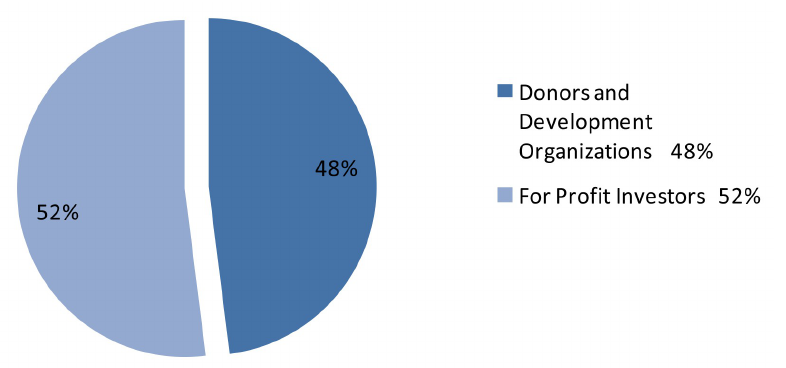
Figure 3. Total Average Committed Funding Amount by Type of Funder (CGAP,